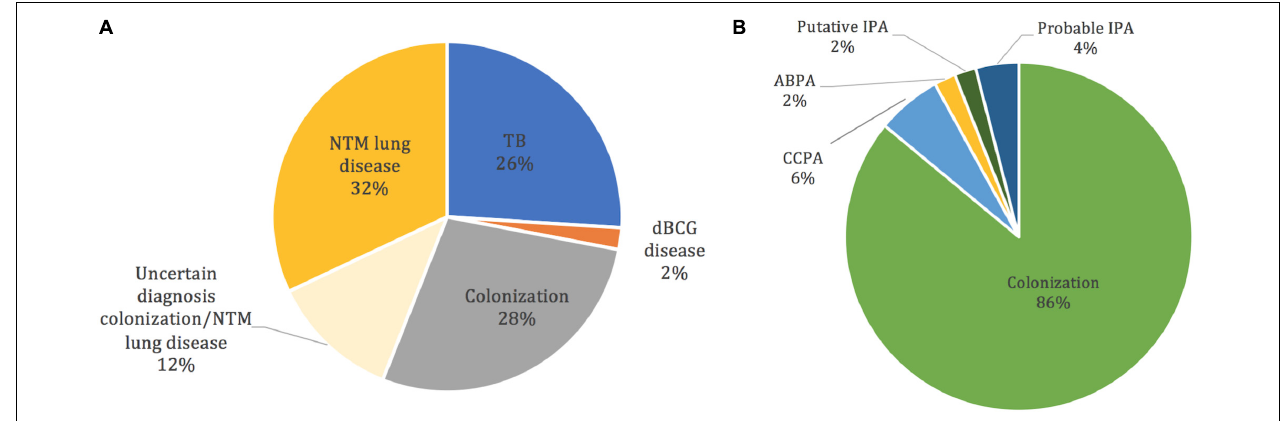
FIGURE 3 | Classification of lung infection or colonization by Mycobacterium spp. and Aspergillus spp. co-isolated in respiratory samples of 50 patients. (A) Pathogenicity of Mycobacterium spp.; M. chelonae , M. gordonae , and M. fortuitum are found in the colonization group only. (B) Pathogenicity of Aspergillus spp. IPA, invasive pulmonary aspergillosis; CCPA, chronic cavity pulmonary aspergillosis; ABPA, allergic bronchopulmonary aspergillosis. dBCG, BCG